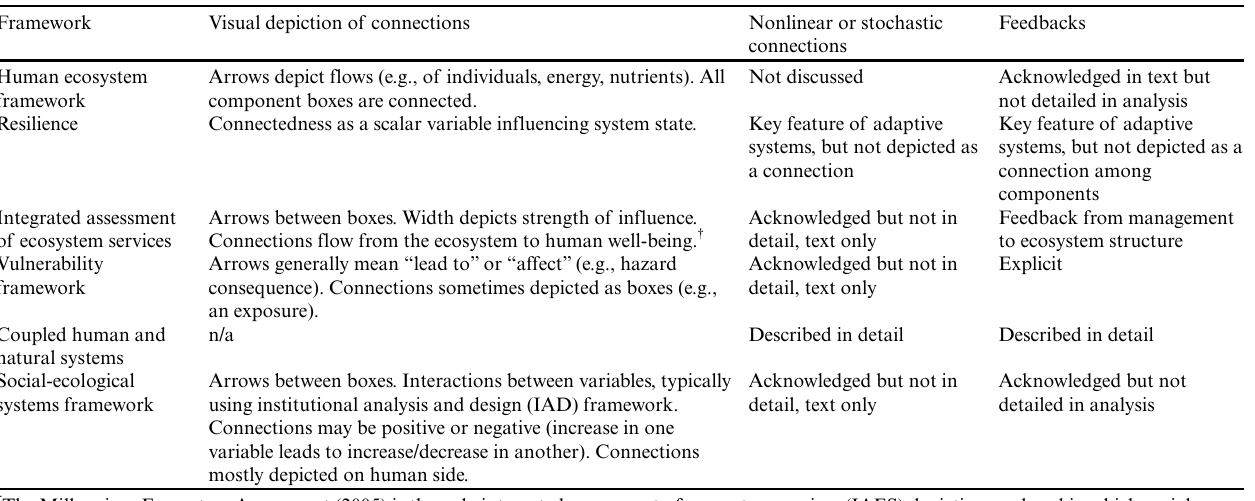
Table 3 . Comparing connections in selected socio-environmental (SE)